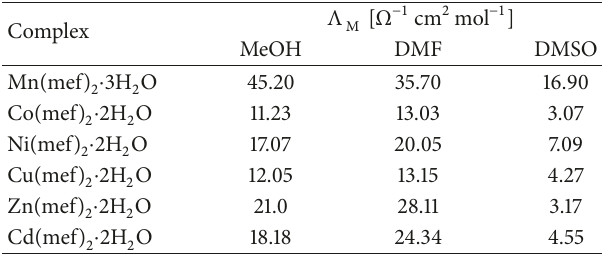
Table 1: Molar conductivity of complexes Λ M / Ω −1 cm 2 ⋅ mol −1 for Table 2: Principal IR bands (cm −1 ) for carboxylate group in investigated complexes.